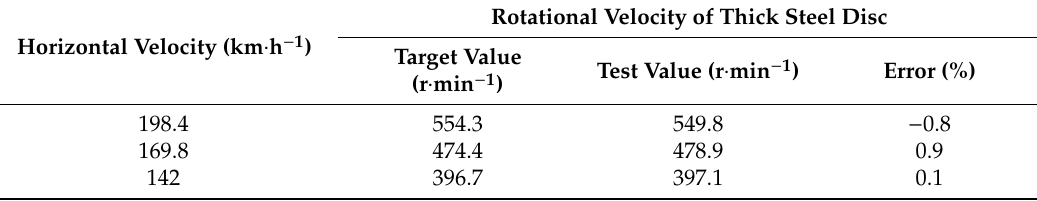
Table 3. Comparison of target value and test result of horizontal